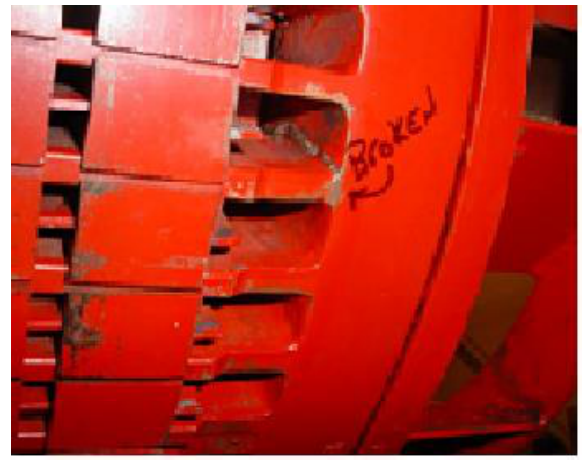
Figure 1. Illustration of: An example of industrial motor (2000 H.P) with broken rotor bars.